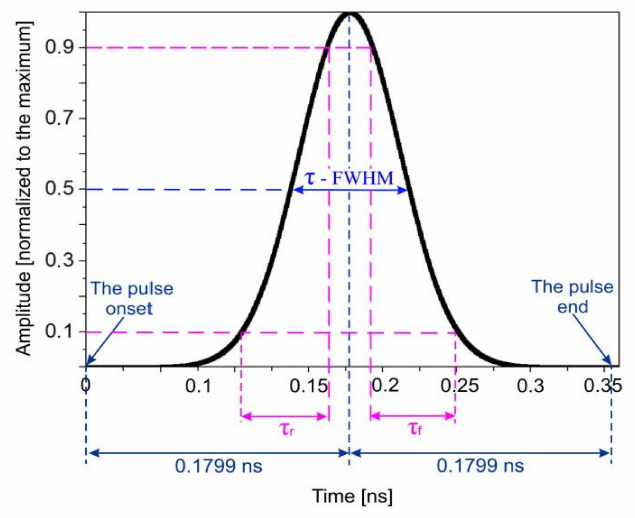
Figure 2. The time dependence of the electric field strength (or the magnetic field strength) of the normalized incident Gaussian EM plane wave